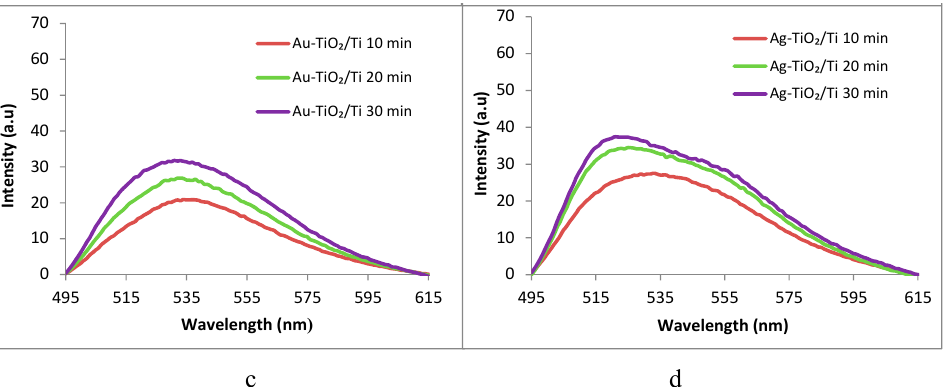
Figure 7. Time course of singlet oxygen formation after exposure to visible light ( λ > 420 nm) in the absence ( a )/presence ( b – d ) of the investigated samples, registered with SOSG singlet oxygen sensor for λ exc = 488 nm.